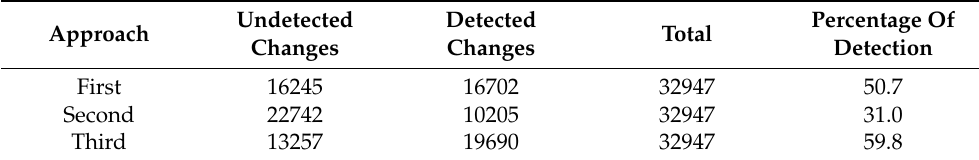
Table 2. Count of real changes identified by at least one pixel.